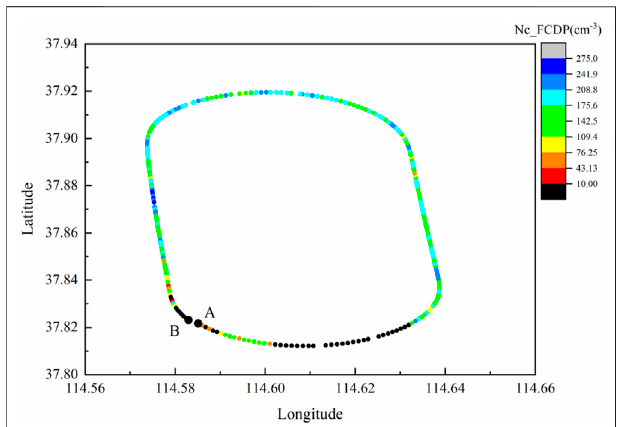
FIGURE 7 | The fl ight trajectory at 5,200 m for the cloud seeding with cloud particle number concentration retrieved from fast cloud droplet probe. Black marks denote that the aircraft was outside the